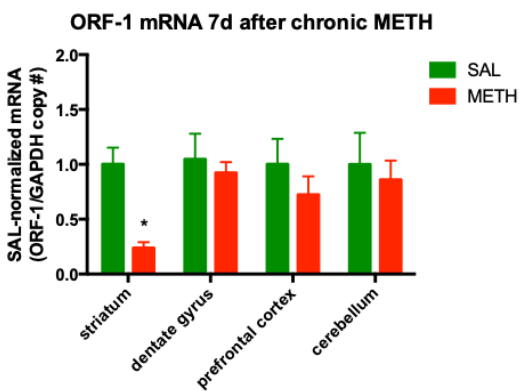
Figure 4. The effect of chronic METH (20 mg/kg/d, for 10 d, i.p.) on ORF-1 mRNA levels in the striatum, dentate gyrus, prefrontal cortex and cerebellum at 7 d after the last dose of METH or saline. Abbreviations: d, day; METH, methamphetamine; SAL, saline. * Statistical significance p < 0.05, METH vs . SAL.